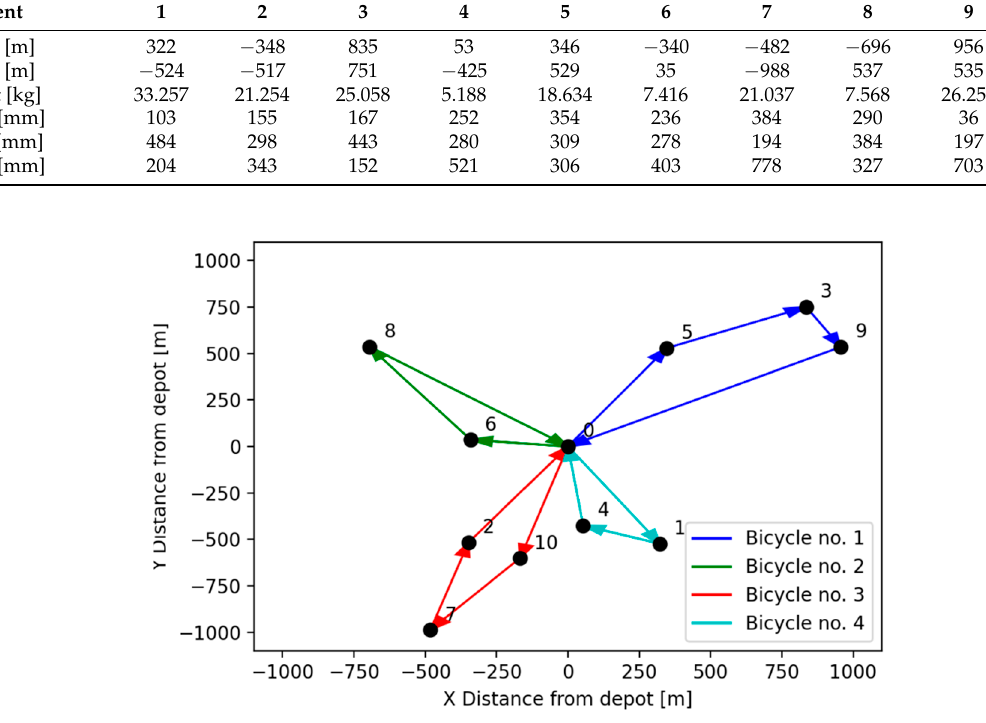
Figure 1. Node location and route with lowest total time.